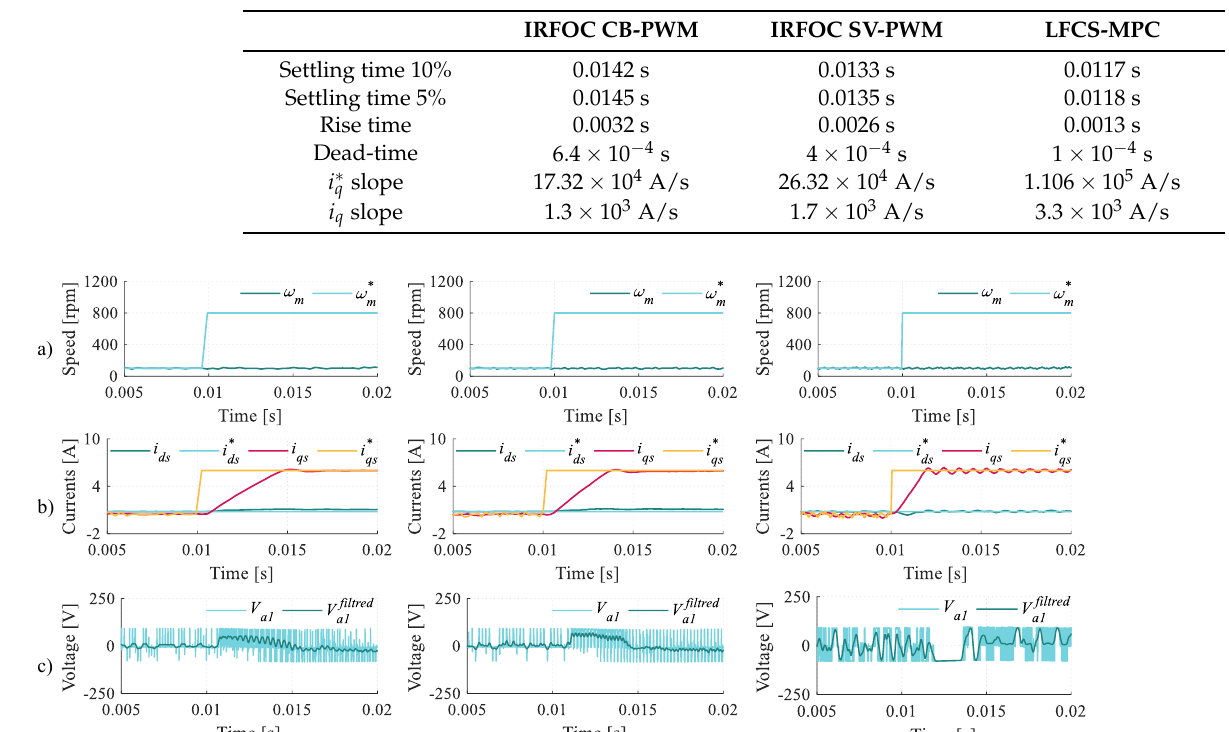
Table 6. Time-response indices for Test 1.